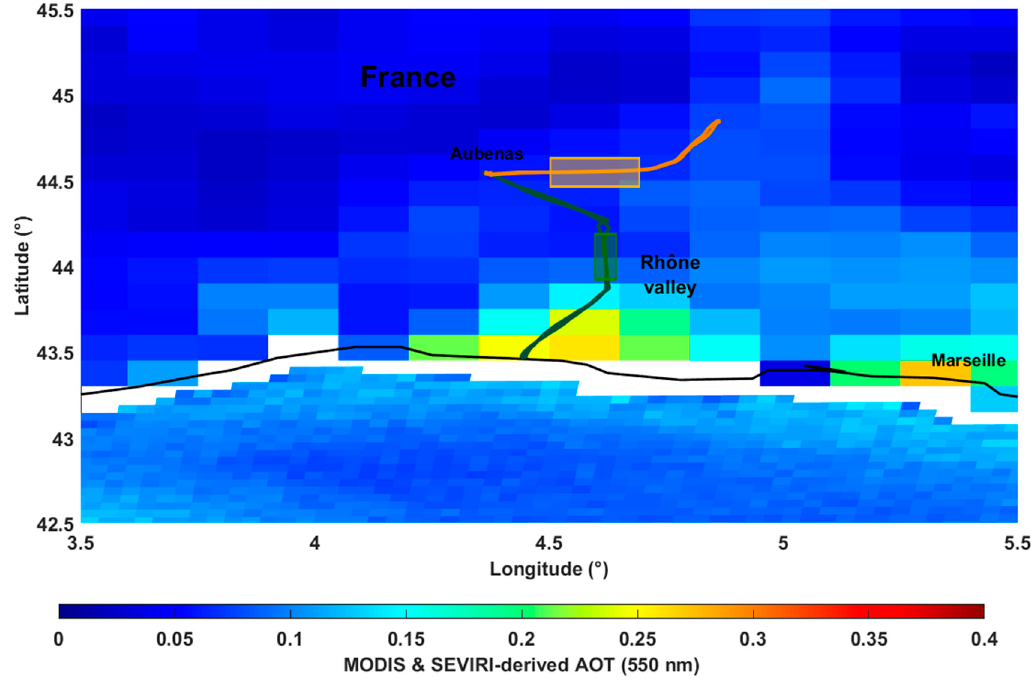
Figure 7. Ground-tracks of flights C (orange) and D (green) on 24 June 2015. The ground-tracks are superimposed to the aerosol optical thickness (AOT) at 550 nm derived by MODIS (over continent) and SEVIRI (over sea). The AOTs are computed between 10:00 a.m. and 2:00 p.m. UTC (universal time count). The framed areas represent the parts of the flight paths where the study is carried out.